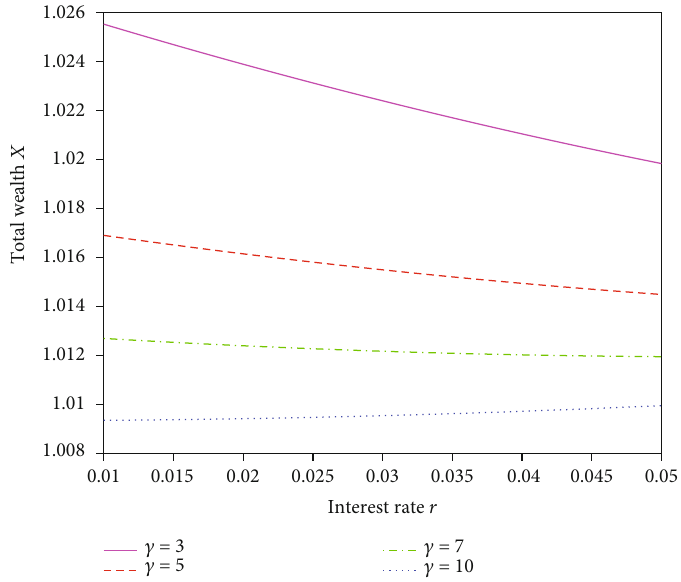
Figure 3: The relationship between total wealth and interest rate under di ff erent SDRAs.